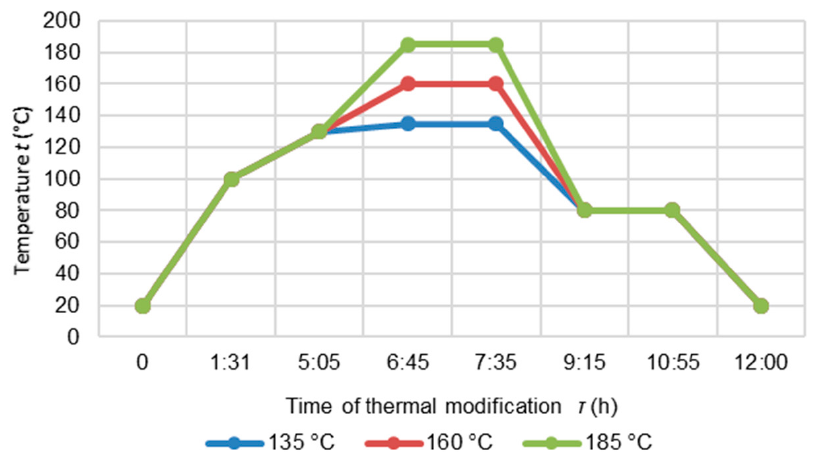
Figure 1. Diagram of the thermal modification process.